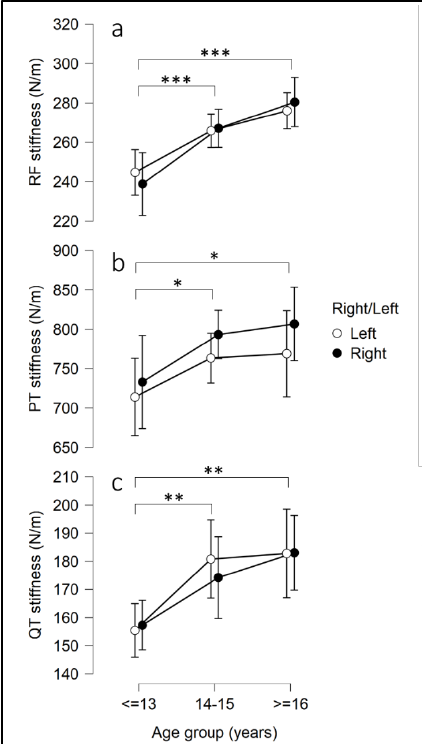
Figure 4. Rectus Femoris muscle stiffness ( a , RF), Patellar Tendon stiffness ( b , PT) and Quadriceps Tendon stiffness ( c , QT) in the three age groups in left and right limbs. Error bars represent a confidence interval of 95%. * = p < 0.05; ** = p < 0.01; *** = p < 0.001.